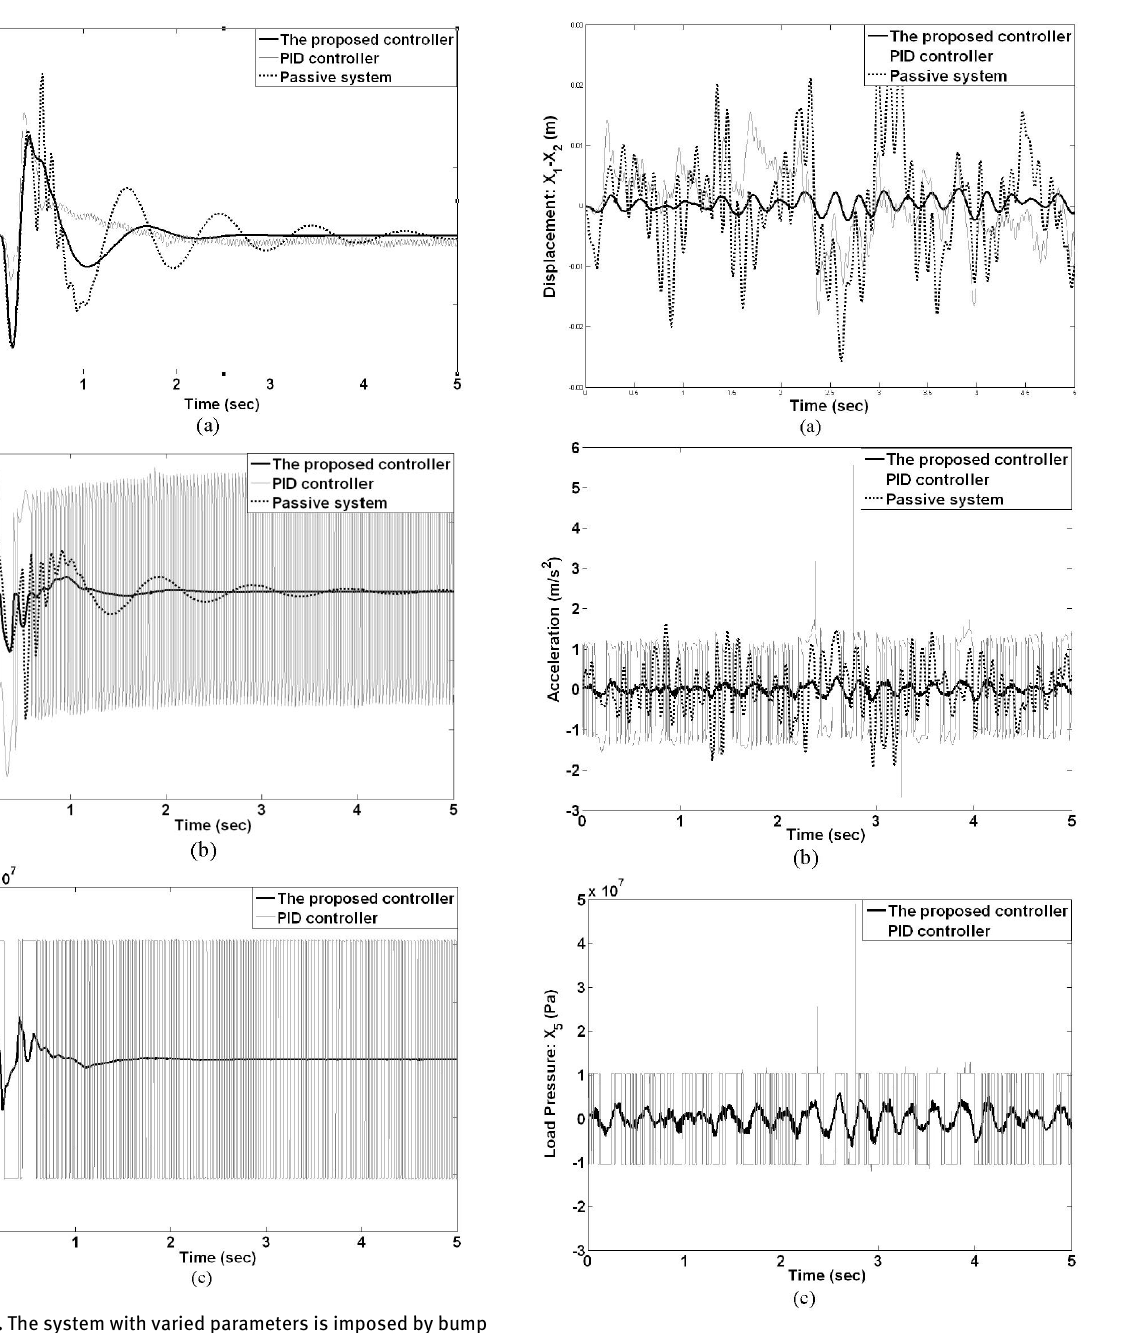
Figure 12. The system with varied parameters is imposed by ran- dom road profile depicted in Fig. 4. (a) Suspension travel for the proposed controller, PID and passive suspension system, (b) Ver- tical vehicle body acceleration for the proposed controller, PID and passive suspension system, (c) Load pressure for the proposed controller and PID displacement, decreasing acceleration and load pressure by using the proposed controller even in the presence of model uncertainty compared with the PID controller